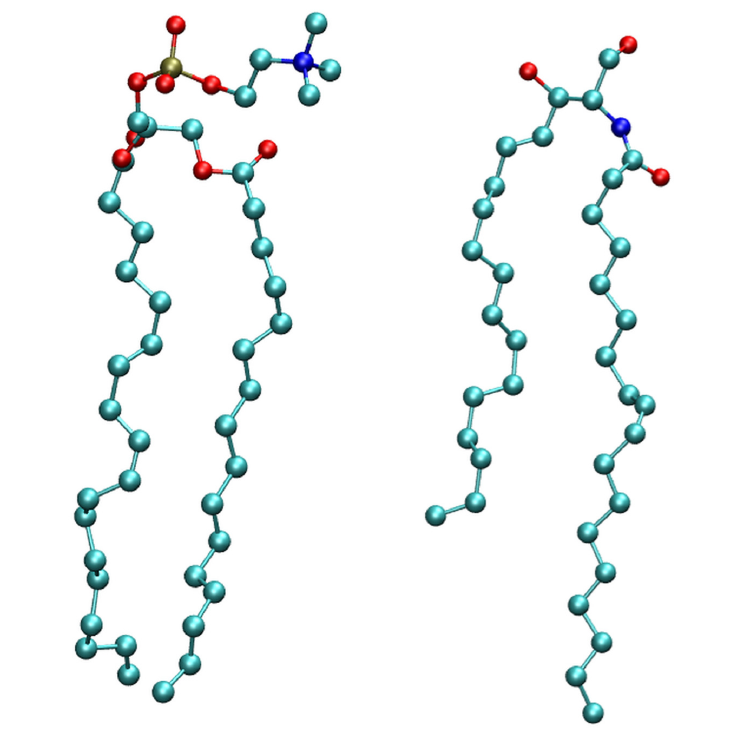
Figure 1. Molecular structure of phospholipids (POPC) ( left ) and ceramides (NODS) ( right ) lipid molecules. Hydrogen atoms are not shown for